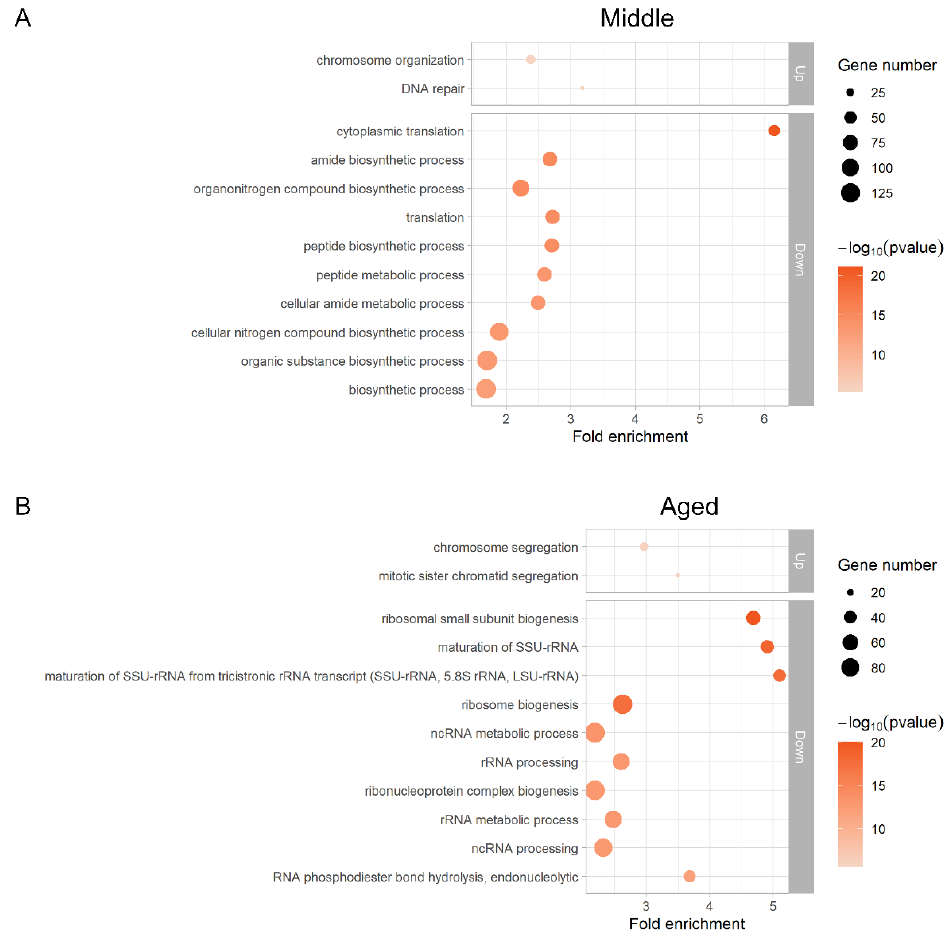
Figure 3. GO enrichment results of genes with significantly changed translational efficiency. Upregu- lated genes with changes of more than twofold compared to Young cells were analyzed ( p < 0.05). Fold enrichment and p -values are shown. The size of the circle indicates the number of genes associ- ated with the GO term. ( A ) Genes with greater than twofold changes in Middle cells. ( B ) Genes with greater than twofold changes in Aged